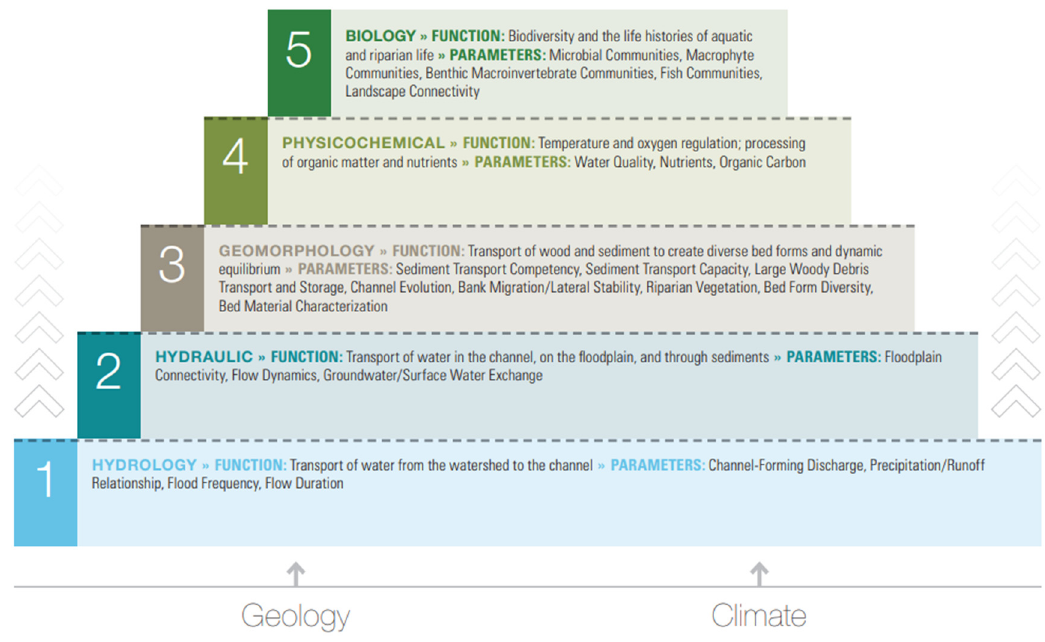
Figure 1. Stream Functions Pyramid Framework, depicting function category statements and function parameters for all five 5 levels of the Pyramid [31]. Reproduced with permissions from Harman et al., A Function-Based Framework for Stream Assessment and Restoration Projects, US Environmental Protection Agency, Office of Wetlands, Oceans, and Watersheds, Washington, DC, EPA 843-K-12-006, 2012.